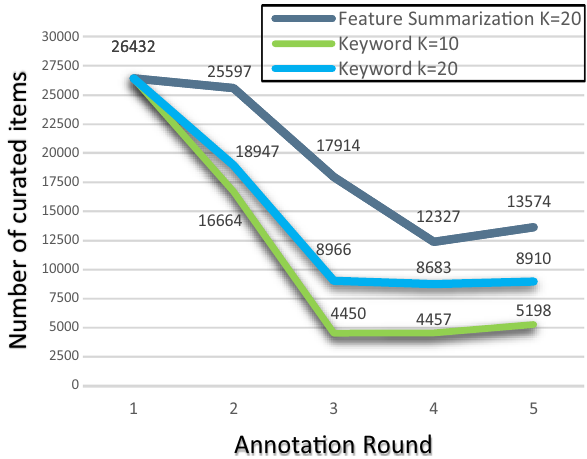
Fig. 7 Comparison between the number of items annotated using conceptual- and syntactic-level features (mental health